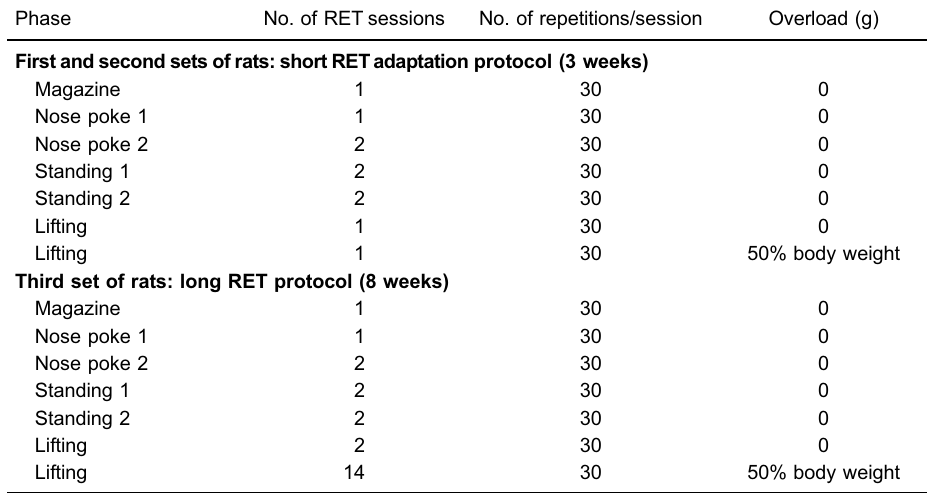
Table 1. Resistance exercise training (RET) protocols applied in the fi rst, second and third sets of rats.